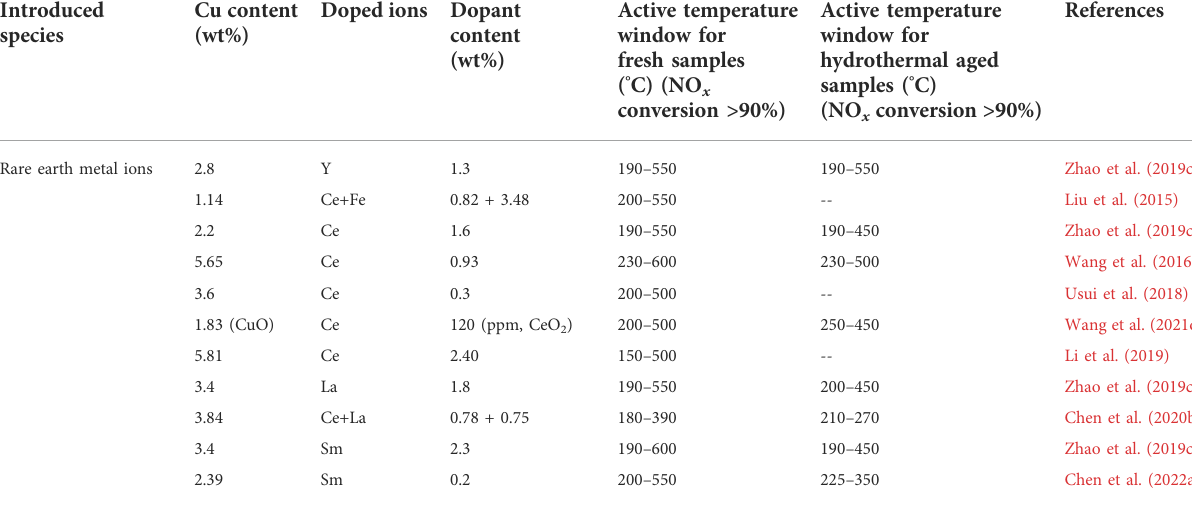
TABLE 3 Summary of the Cu-SSZ-13 catalysts doped with rare earth metal ions. Introduced